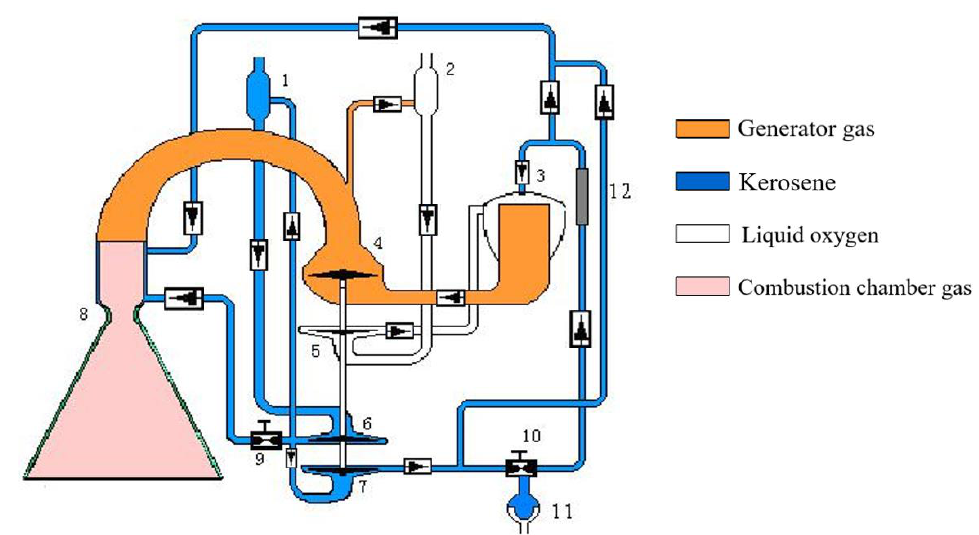
Figure 1. The functional block diagram.